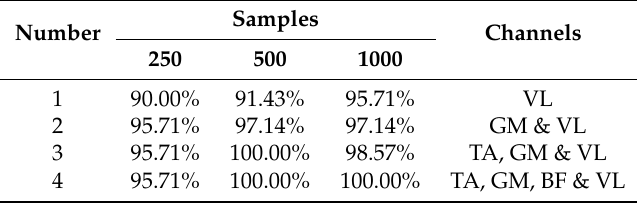
Table 1. Best accuracy results obtained among the eight subjects.